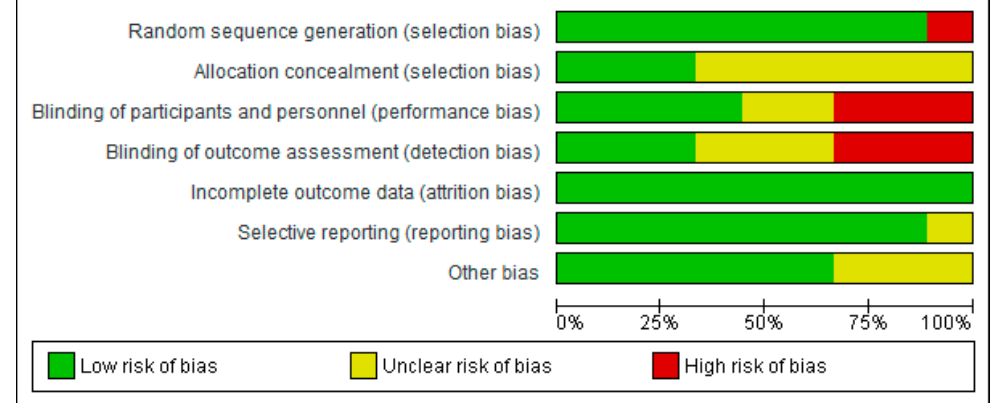
Figure 2. Risk of bias graph: Review authors’ judgments about each item presented as percentages across all included studies.